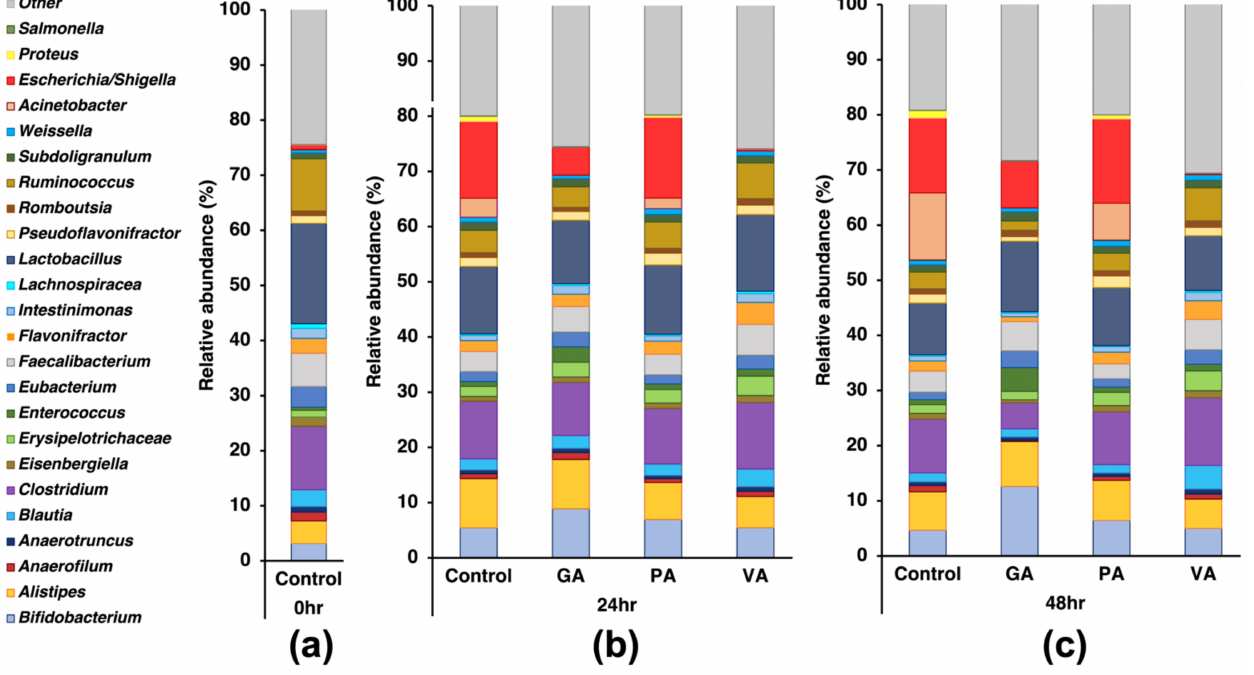
Figure 3. Relative percentage of abundance of microbes at the genus level for the top 25 genera in 16S-rRNA gene sequencing data at 0 h ( a ), 24 h ( b ), and 48 h ( c ) for an untreated control and groups individually treated with either gallic acid (GA), protocatechuic acid (PA) and vanillic acid (VA). At the 48 h timepoint for the untreated control, the top four major phyla remained the same as at 24 h with a numerical decrease in the relative abundance of Firmicutes (57.50%) and Actinobacteria (5.13%), while there was an increase in Proteobacteria (28.59%)